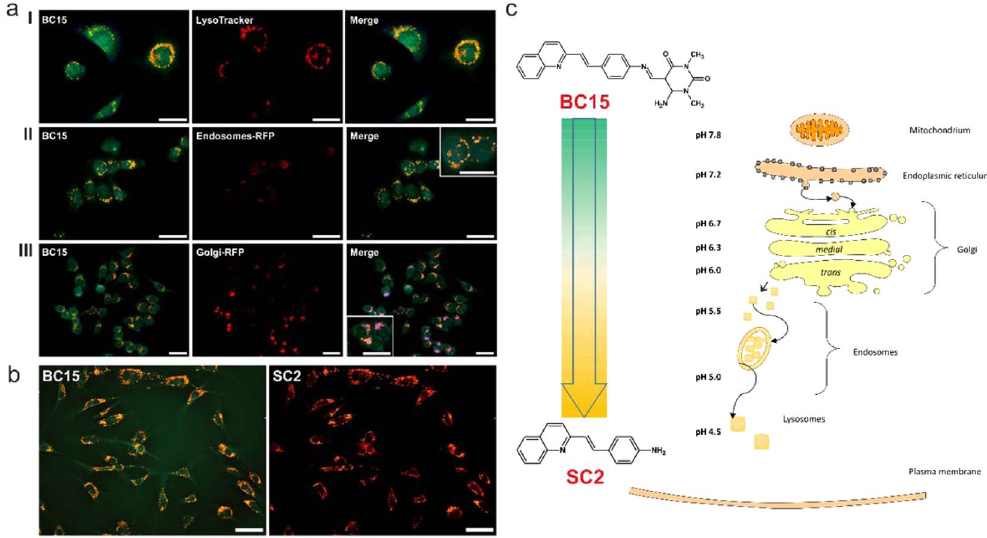
Figure 4. Fluorescence images of the HCT 116 cells that had been incubated with BC15 (25 µ M) for 2 h at 37 °C. ( a ) BC15 was excited by a DAPI (UV-2A filter; excitation wavelength 330–380 nm; barrier filter BA420). The images show a co-localization with specific organelle trackers: lysosomes (I), endosomes (II) and the Golgi apparatus (III). First and second panel – fluorescence of the BC15 or specific dye alone, last panel – merged (red-orange indicates colocalization of BC15 with specific-organelle tracker, magenta indicates area where no colocalization was observed). ( b ) Fluorescence images of the NHDF cells that had been incubated with BC15 (25 µ M for 2 h at 37 °C) excited by a DAPI (UV-2A filter; excitation wavelength 330–380 nm; barrier filter BA420) ( BC15 ) and (B-2A filter; excitation wavelength 450–490 nm; barrier filter BA520) ( SC2 ). Scale bars indicate 50 µ m. ( c ) Representation of the BC15 decomposition in the acidic